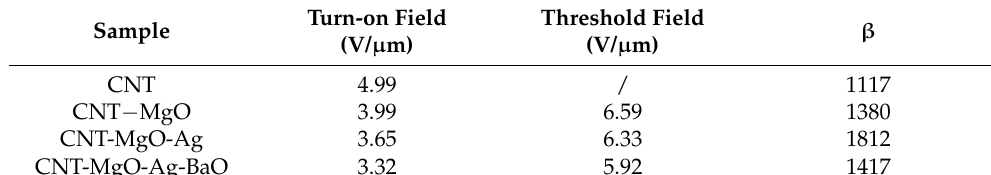
Table 1. Comparison of FE parameters of CNT − based samples.